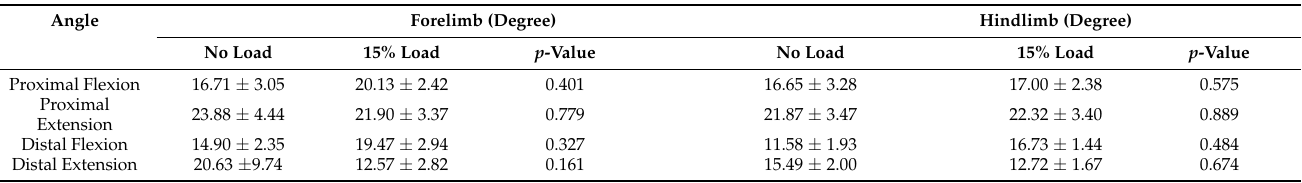
Table 2. Median ( ± standard error (SE)) maximal flexion and extension angles of fore- and hindlimb joints and changes in Asian elephants walking with only a mahout on the neck (no load) and with an additional 15% of body mass load. Angle Forelimb (Degree) Hindlimb